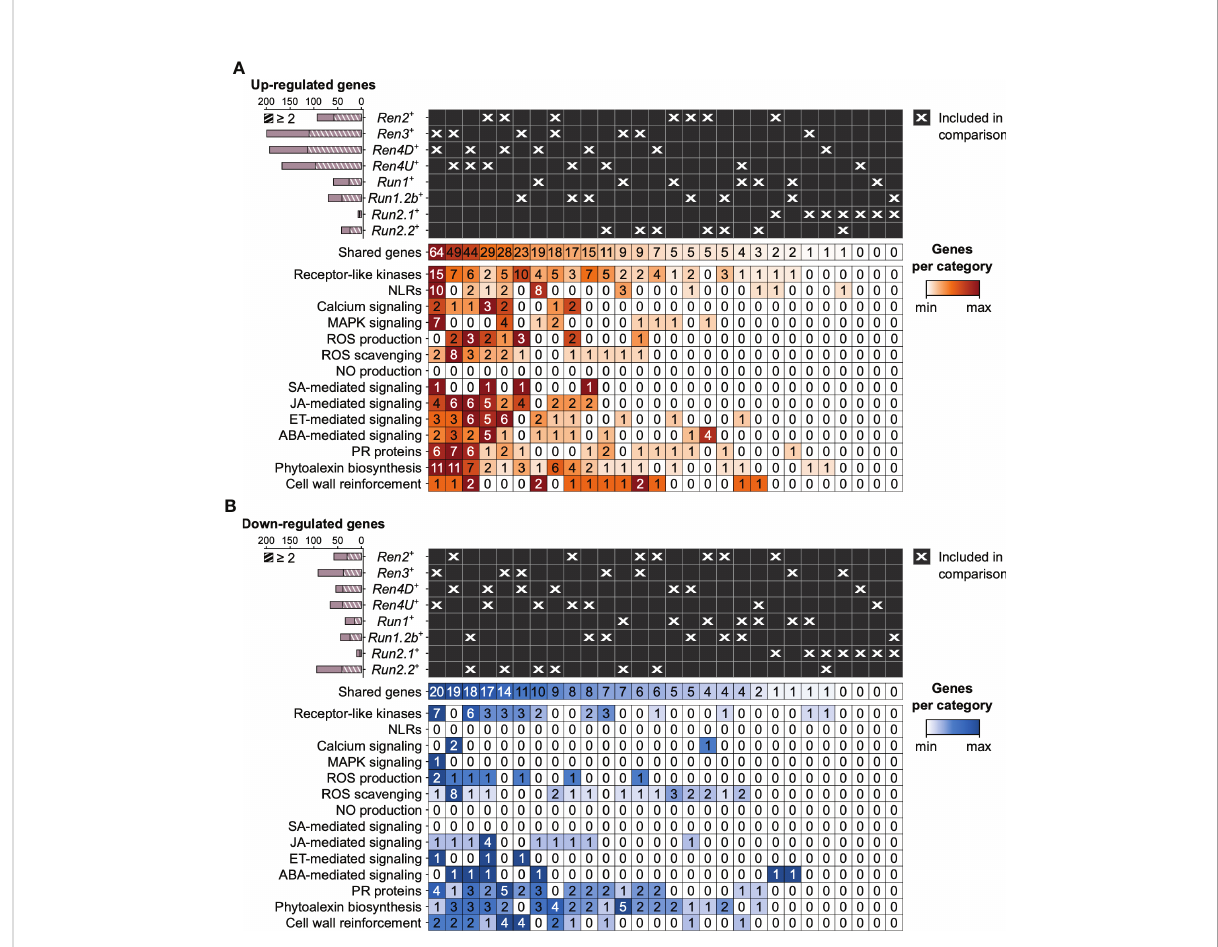
FIGURE 5 Pairwise comparison of the defense-related genes found up- (A) and down-regulated (B) in response to E. necator at 1 dpi in only the eight R loci. Striped bar plots depict the number of defense-related genes differentially expressed in at least two R